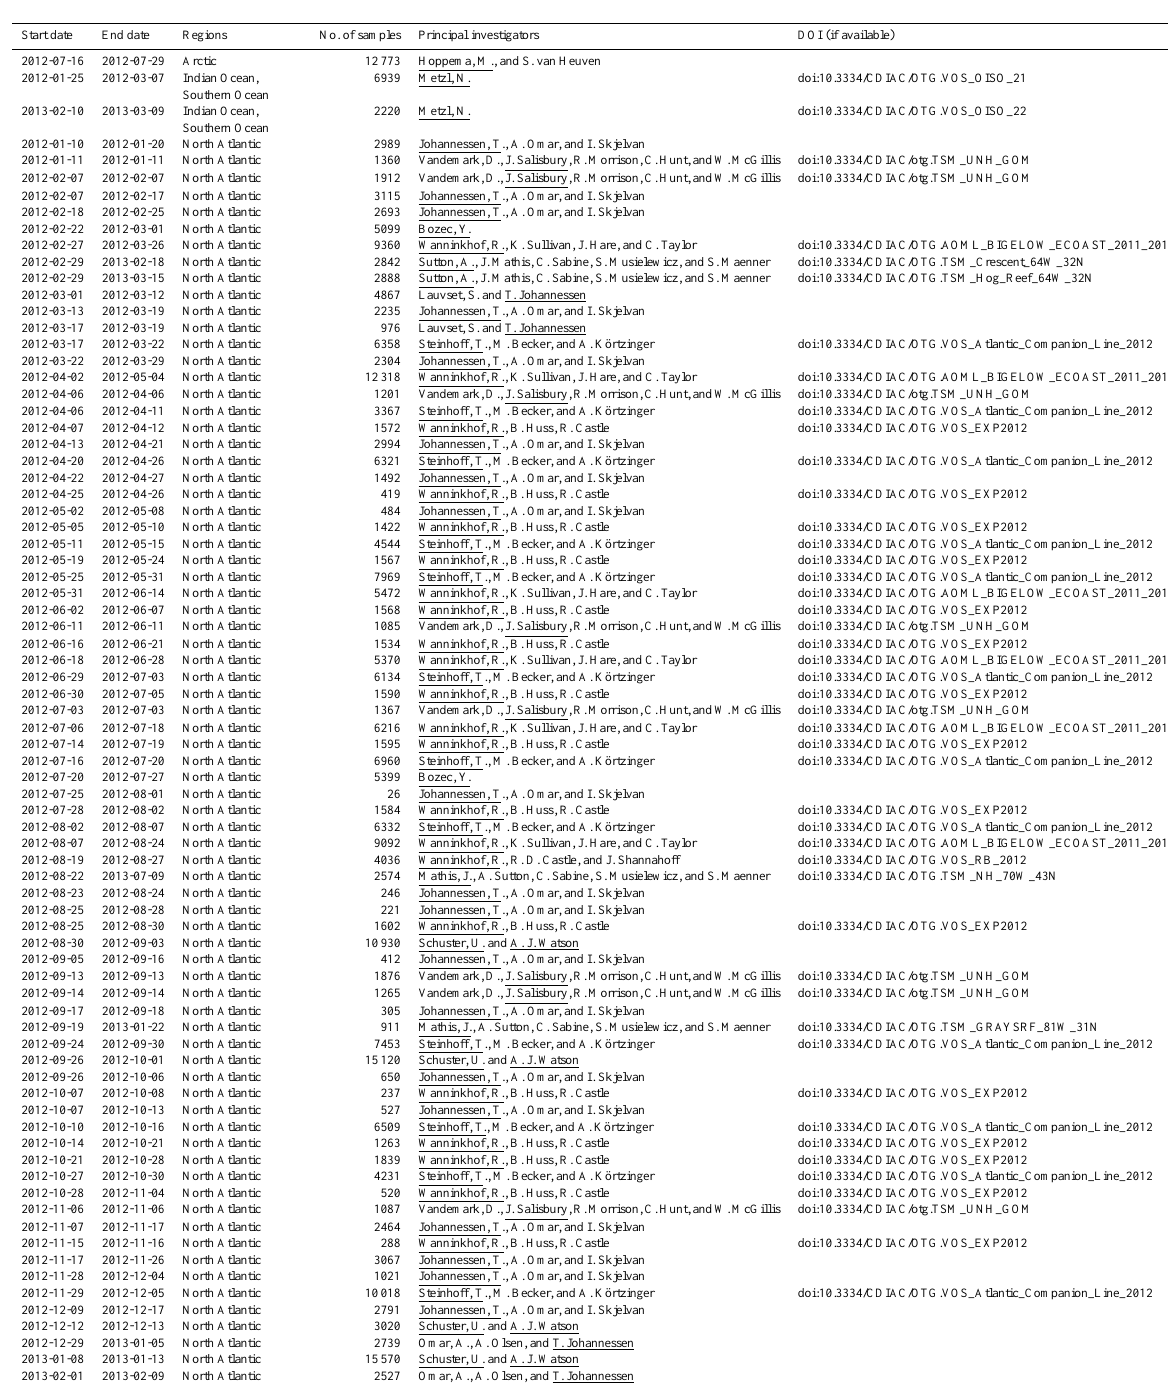
Table A1. Attribution of f CO 2 measurements for years 2012–2013 used in addition to SOCAT v2 (Bakker et al., 2014) to inform ocean data